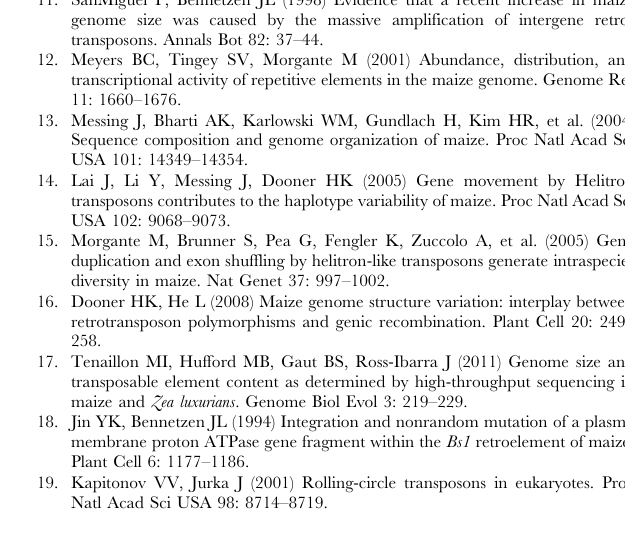
Table S5 GO annotation of regulated genes at each trans- eQTL hotspot. The GO enrichment analysis of the regulated genes at each trans- eQTL hotspot was conducted using BiNGO plugin in Cytoscape based on the annotation information from AgriGO. Table S6 MaizeCyc enrichment of regulated genes at each trans- eQTL hotspot with at least 200 targets. The pathway enrichment of the regulated genes by hotspots was conducted using BiNGO plugin in Cytoscape based on the annotation information from MaizeCyc database. Table S7 The number of expressed genes intersecting with CNV/PAV. Mo17 . B73_CNV shows segments that are predicted to occur in more copies in Mo17 than in B73. B . M_CNV indicates segments containing significantly more copies in B73 than in Mo17, while B . M_int represents segments having intermediate more copies in B73 than in Mo17. B . M_PAV shows segments present in B73 but absent in Mo17. Table S8 Expression of genes entirely within CNV/PAV regions. a indicates the number of genes with expression level of B73 significantly higher than Mo17; b represents the number of genes with expression level of B73 significantly lower than Mo17; c shows the number of genes with no expression changes between B73 and Mo17. Mo17 . B73_CNV shows segments that are predicted to occur in more copies in Mo17 than in B73. B . M_CNV indicates segments containing significantly more copies in B73 than in Mo17, while B . M_int represents segments having intermediate more copies in B73 than in Mo17.